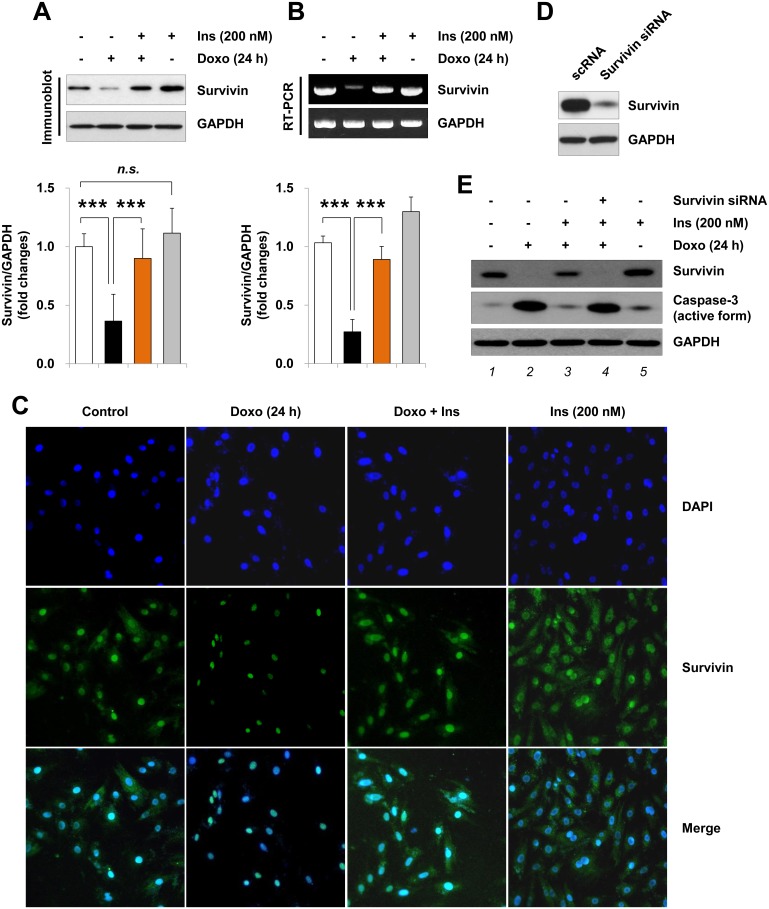
Inhibitory effect of insulin on the doxorubicin-induced survivin down-regulation.(A, B) Serum-deprived H9c2 cardiac myocytes were left untreated or pretreated with 200 nM insulin (Ins) for 1 h and treated with 1 μM doxorubicin (Doxo) for 24 h. (A) Whole cell lysates were separated by SDS-PAGE gel and analyzed by immunoblotting with anti-survivin antibody. Graph represents the mean ±S.D. of the normalized densitometric analysis of survivin protein levels from 8 independent experiments (***p < 0.001, n = 8). (B) Total RNA was analyzed by RT-PCR (28 cycles) using primers specific to survivin gene. Graph represents the mean ±S.D. of the normalized densitometric analysis of survivin mRNA levels from 3 independent experiments (***p < 0.001, n = 3). (C) Immunofluorescence microscopy images were obtained using anti-survivin antibody followed by staining with DAPI (200×). (D, E) One day after transfection with either scrambled RNA (scRNA) or survivin siRNA (20 nM), H9c2 cardiac myocytes were left untreated or pretreated with insulin (200 nM) for 1 h and treated with doxorubicin (1 μM) for 24 h. Whole cell lysates were blotted with antibodies against survivin and cleaved-caspase-3 (active form). Note that the blots in panel D and E represent one of three independent experiments. n.s. not significant.